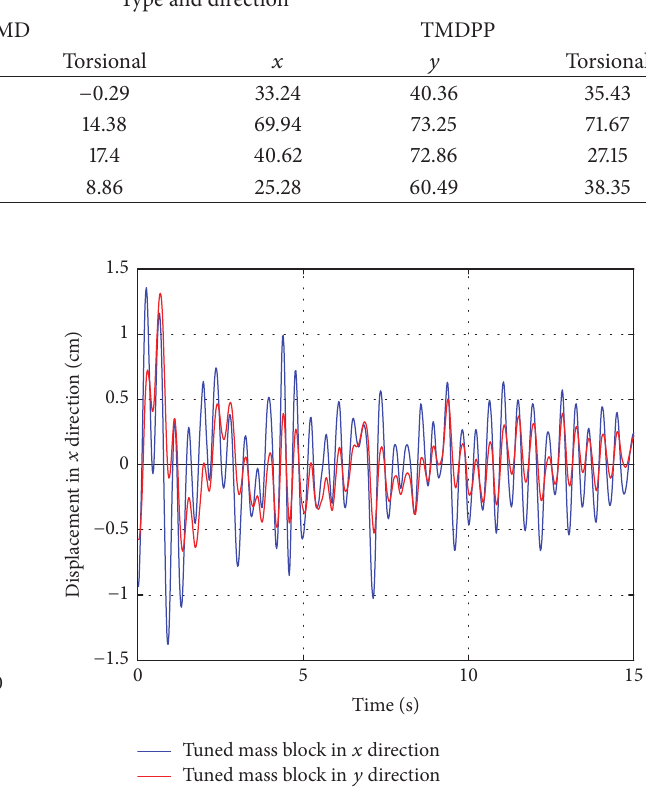
Figure 11: Damping comparison of structural torsion angle. Figure12:Displacementhistoryoftunedmassblocksin 𝑥